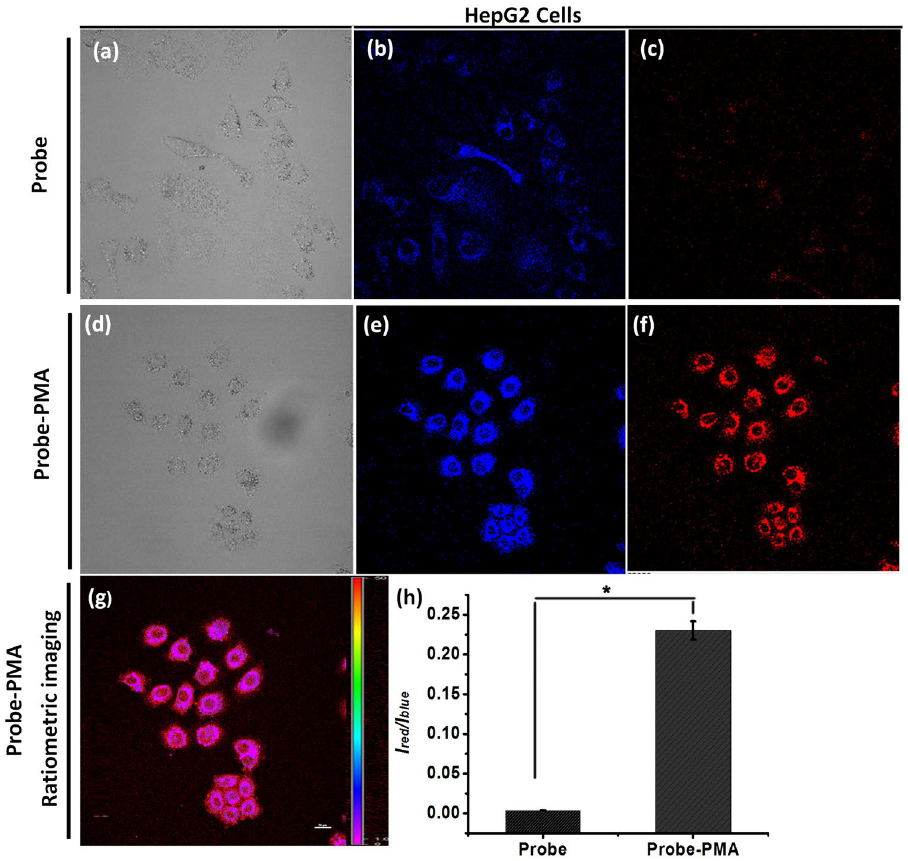
Figure 8. ( a ) Bright-field image of cells untreated with PMA, ( b ) Images of cells untreated with PMA in the blue emission channel ( λ ex = 405 nm, λ em = 425–475 nm); ( c ) Images of cells untreated with PMA in the red emission channel ( λ ex = 405 nm, λ em = 570–620 nm); ( d ) Bright-field images of cells treated with PMA; ( e ) Images of cells treated with PMA in the blue emission channel ( λ ex = 405 nm, λ em = 425–475 nm); ( f ) Images of cells treated with PMA in the red emission channel ( λ ex = 405 nm, λ em = 570–620 nm); ( g ) Ratiometric images of cells untreated with PMA. ( h ) The ratio of emission intensities profiles in HepG2 cells untreated and treated with PMA. Scale bar = 20 μ m. Statistical analyses were performed with a Student’s t -test ( n = 4). * P < 0.001 and the error bars represent standard deviation ( ±